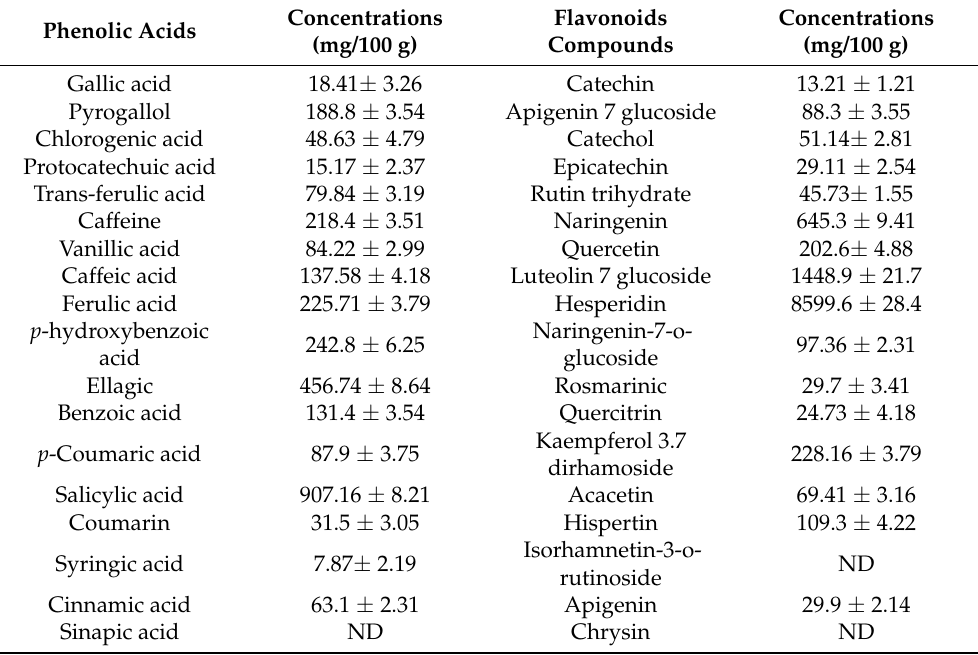
Table 3. Identification of phenolic and flavonoid contents of water extract for the (gin- ger:thyme:coriander) mixture by